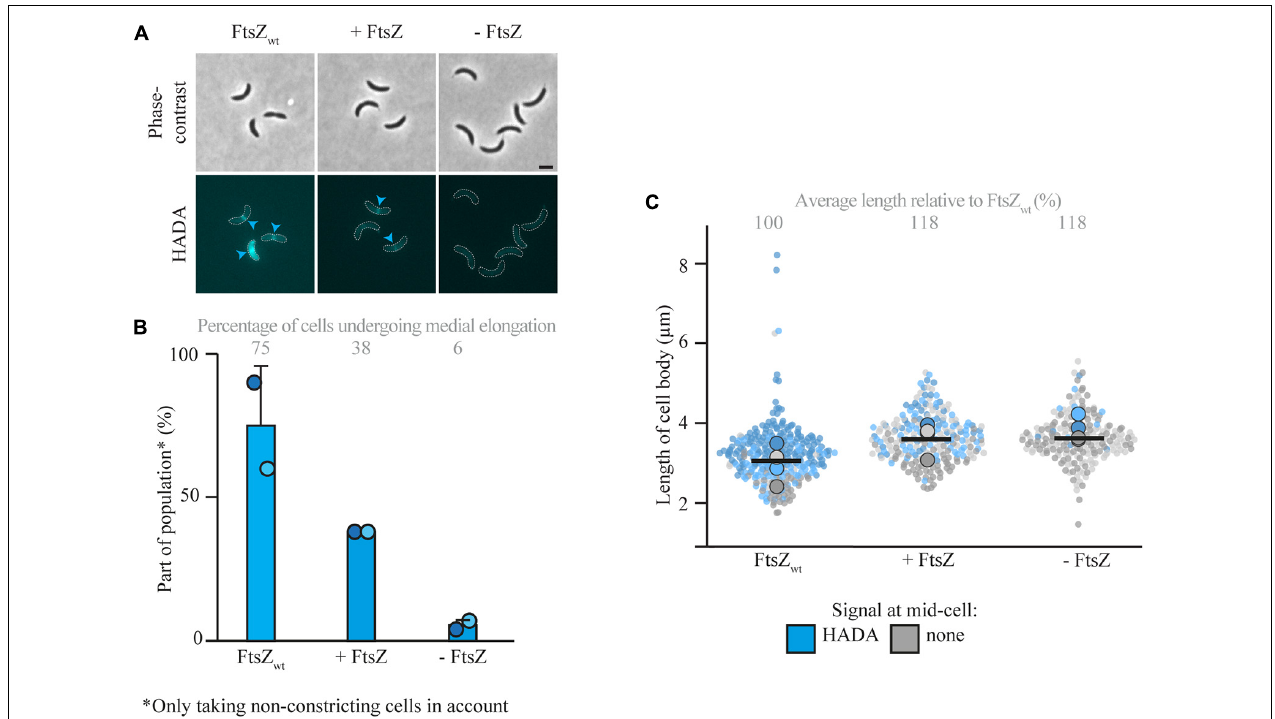
FIGURE 4 | Medial elongation is affected by the absence of FtsZ. Light microscopy images (A) and respective quantification (B) of FtsZ depletion strain YB1585 (grown under depleting and inducing conditions) and MT309 (P xyl - venus-mreB ), synchronized and subsequently grown for 45 min and subsequently subjected to a short pulse HADA staining. Cells in the representative images (A) are outlined and HADA midcell localization is indicated by blue arrowheads. Quantification of fluorescence signals (B) at midcell (using the color scheme outlined above) was performed on 100 non-constricting cells per replicate for two replicates per timepoint (value for each replicate is indicated by circles, replicate 1 is shown in a darker shade and replicate 2 in a light shade). Bars indicate the average of two replicates and error bars indicate standard deviation. In addition, the average percentage of non-constricting cells showing HADA is given for each timepoint. Data shown for FtsZ wt in both cases are from the same replicates of strain MT309 as shown in Figure 1 . Analysis of the cell length (C) of cells of strain YB1585 shows that they are slightly elongated as compared to cells harboring FtsZ wt . Cell lengths are shown in superplots, where each small dot indicates the value for a single cell. The color of each dot follows the color scheme outlined above, in order to identify differences in cell length for the different subpopulations, and shows different shades to differentiate between the replicates. The large dots show the average cell length for each localization subpopulation per replicate. The horizontal black bar indicates the average length over all cells and the numbers above the graph express this average length as a percentage of the average length of the cells carrying MreB wt after 45 min (strain MT309, indicated in Figure 1